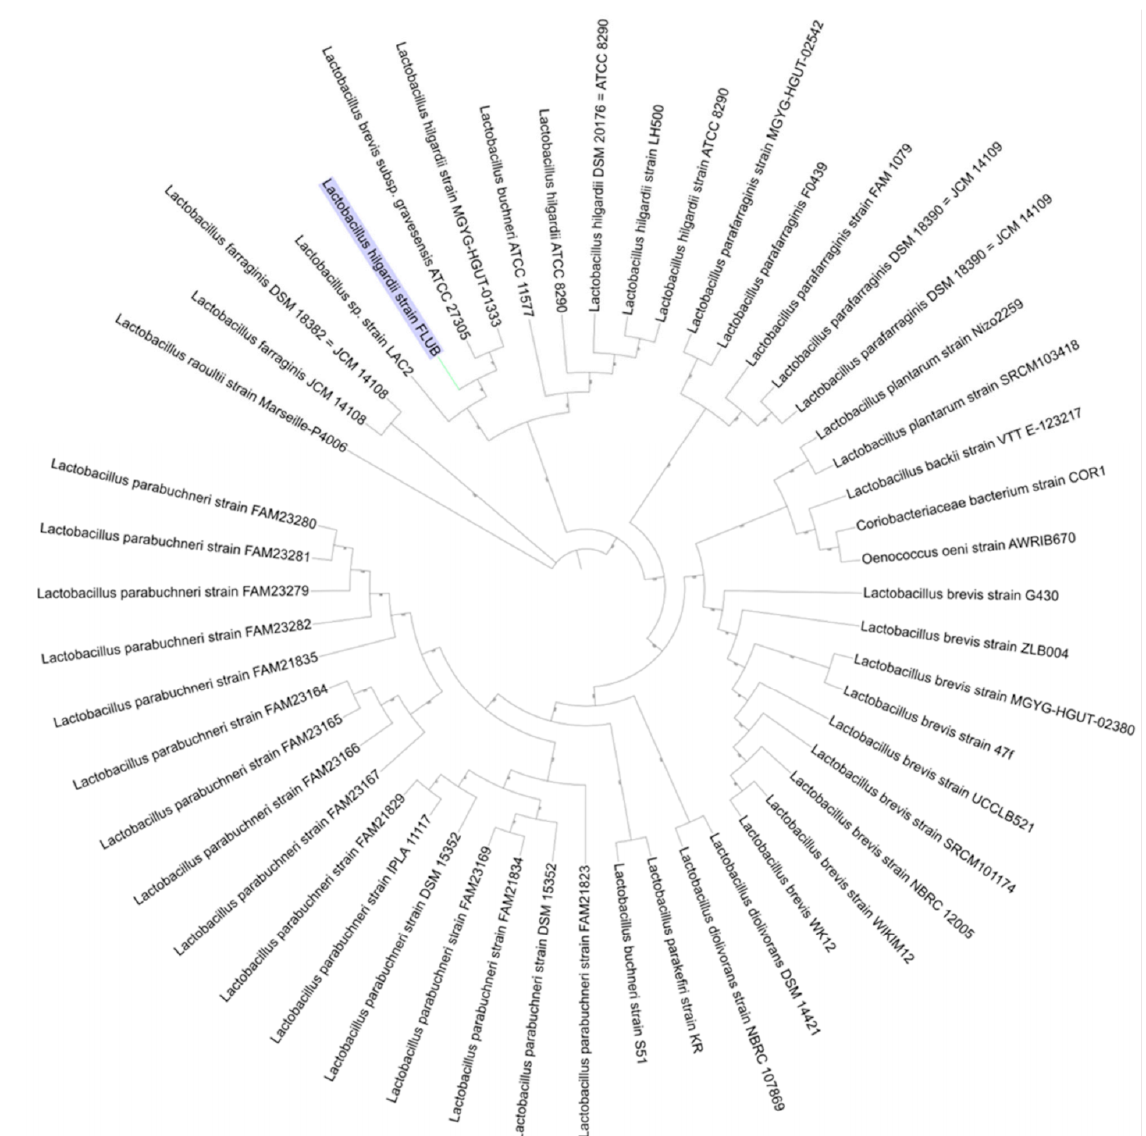
Figure 3. Phylogenetic tree based on PGFams, visualized in iTOL. Although average nucleotide identity (ANI) does not implement paralogous gene filtering for each predicted dDDH value, this analysis has located much closer relatives.